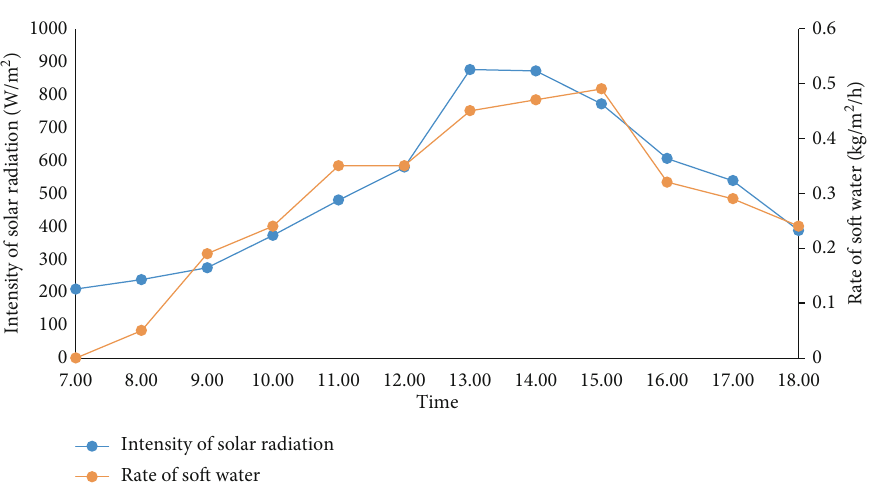
Figure 10: Rate of generation and solar intensity versus time (Mylar on CPC).